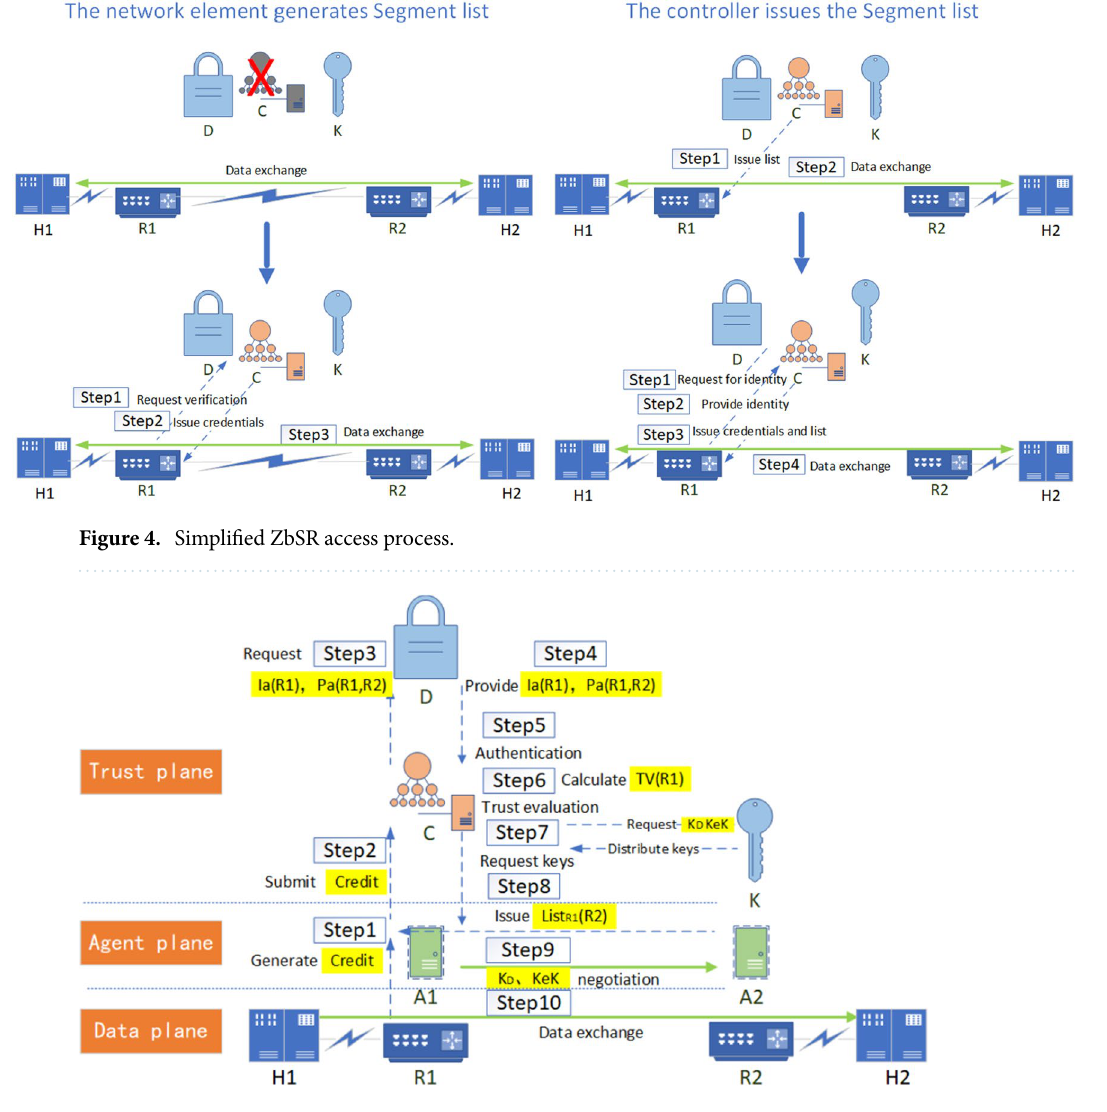
Figure 5. Data exchange process in the mode for the network element to generate Segment